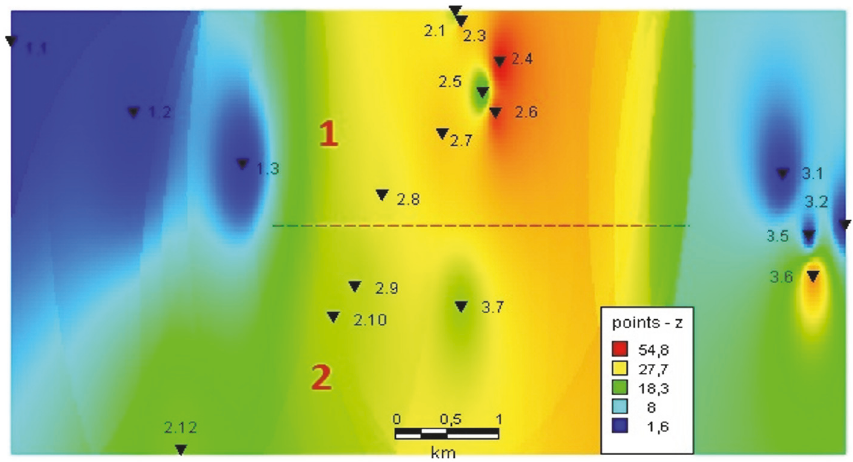
Figure 2: GIS-distribution of